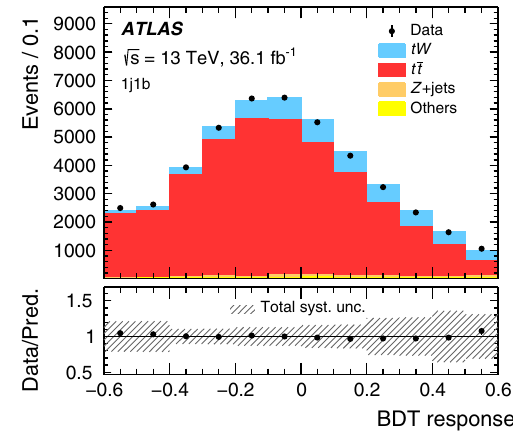
Fig. 4 Comparison of data and MC predictions for the BDT response in the signal region. The tW signal is normalised with the measured fiducial cross-section. Uncertainty bands reflect the total systematic uncertainties. The first and last bins contain underflow and overflow events,